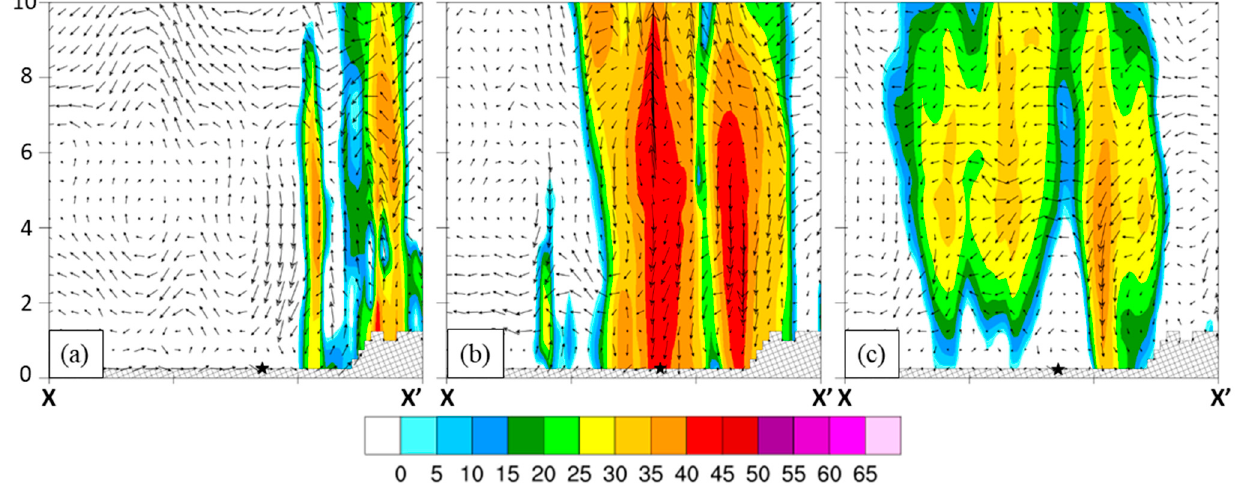
Figure 11. Vertical cross section of maximum reflectivity and horizontal wind vector of NDA02 simulations at ( a ) 0600, ( b ) 0700, and ( c ) 0800 UTC (from 1400 to 1600 LST) on 5 August 2018, along the northwest-to-southeast plane (from x to x’) depicted in Figure 9. The title of each chart showed the accurate location of reflectivity we selected and the approximate location of Pingtung Air Force Base was depicted as black star.